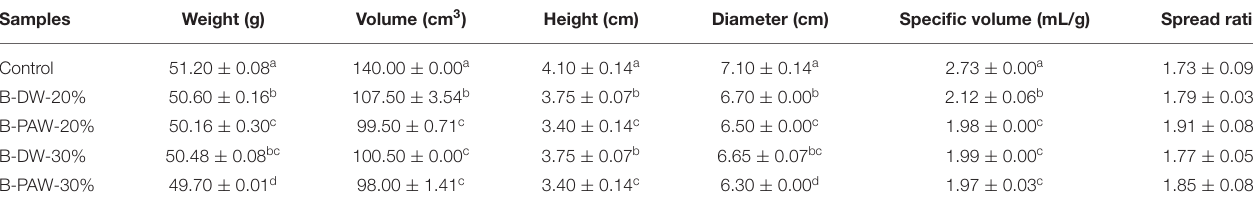
TABLE 2 | Basic indicators of steamed bread. Samples